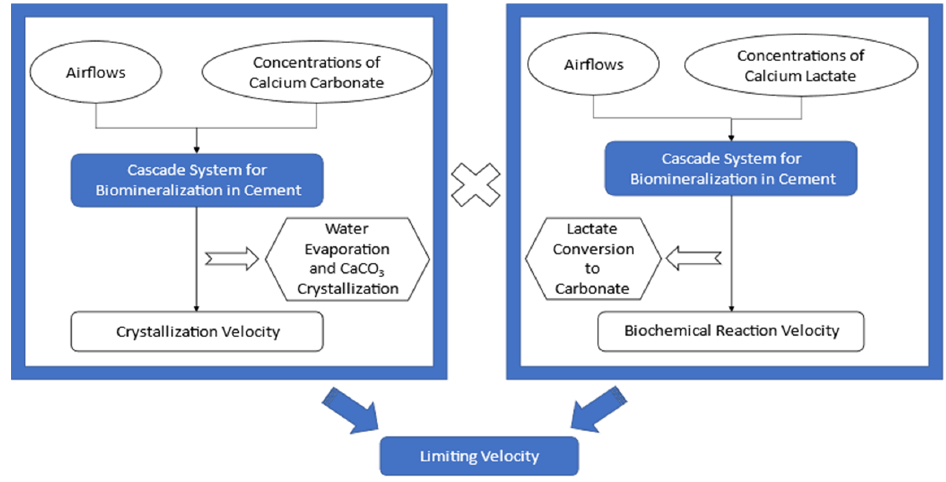
Figure 4. Process diagram of further experiments for the Cascade System for Biomineralization in Cement.